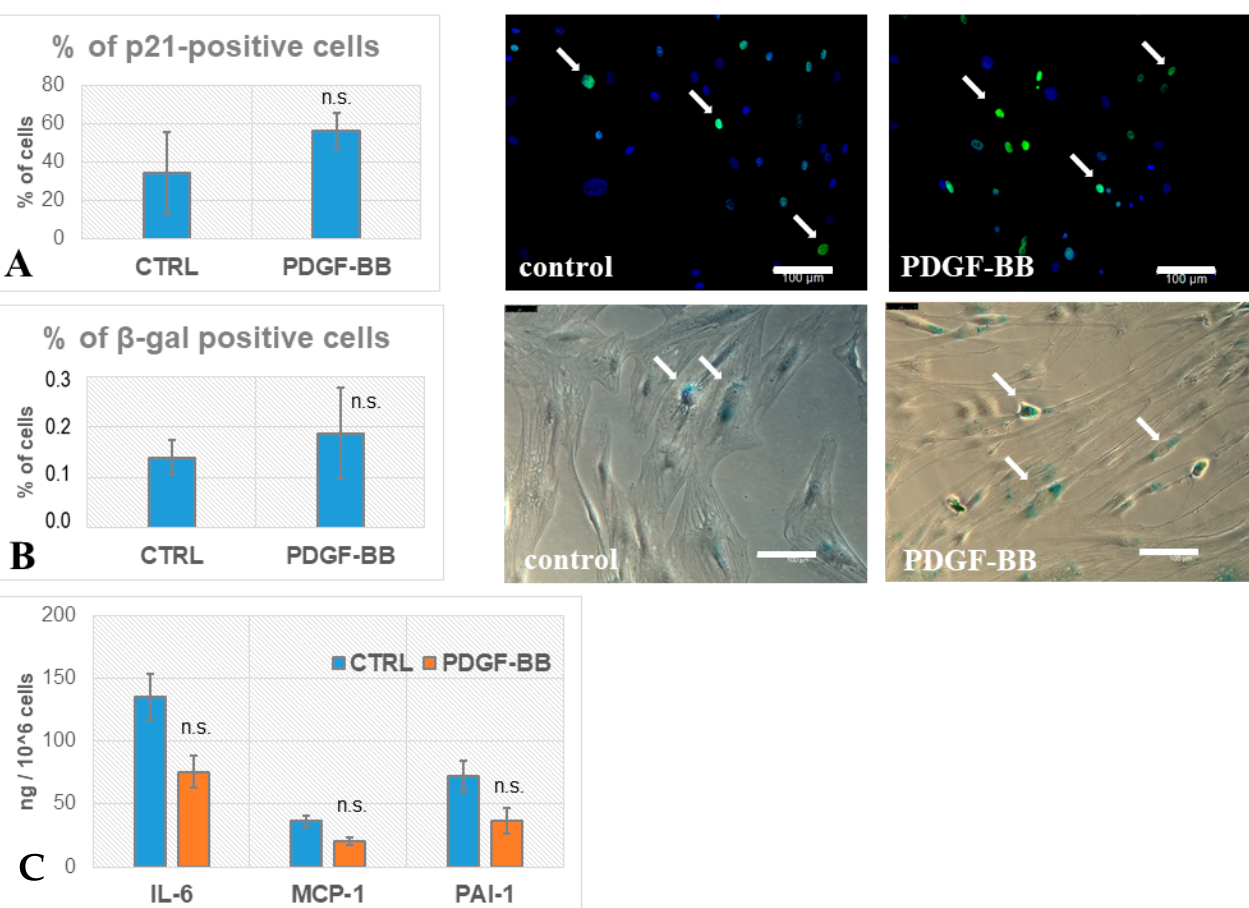
Figure 3. GO BP down/upregulated genes heatmap, 12 and 24 hours after PDGF ‐ BB treatment of human adipose ‐ derived MSCs. The values represent − log10( p ‐ value) for enrichment.